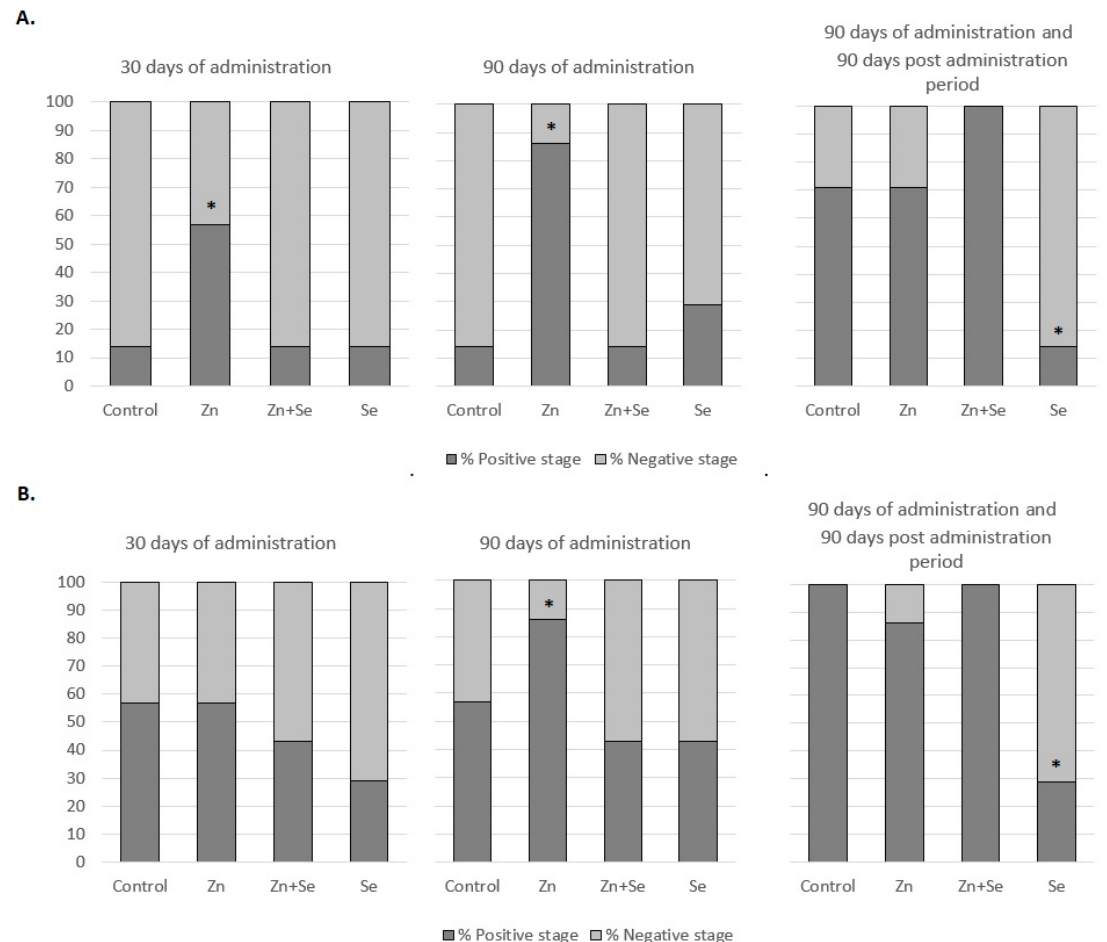
Figure 1. Percentage of rats with an androgen receptor (AR)-positive state in rat ventral (V) ( A ) and dorso-lateral (DL) ( B ) prostate lobe after 30 and 90 day administration of Zn and / or Se, and after 90 days exposure with an additional 90 day post-administration period. * results statistically significant in comparison with control group, p ≤ 0.05